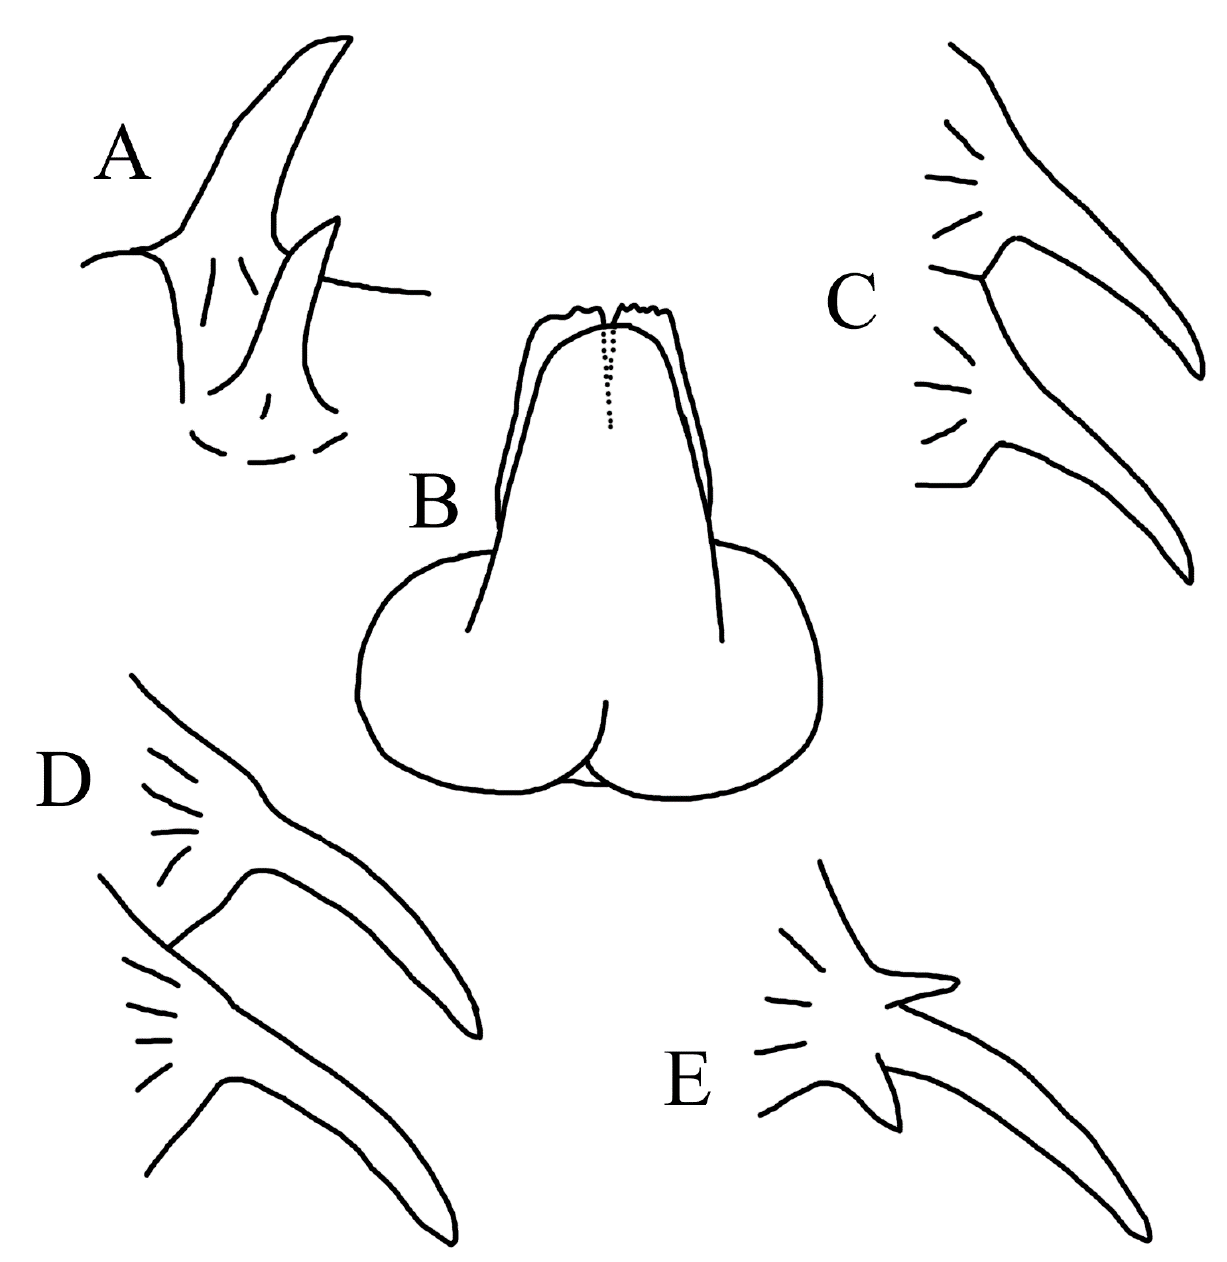
Figure 12. Esca and squamation of H. ingerorum Bradbury, 1988, from MNHN 1986-0027, 70.1 mm SL. ( A ). Rostral tubercles. ( B ). Esca. ( C ). Tubercles on disk margin. ( D ). Tubercles on tail. ( E ). Subopercular tubercle.